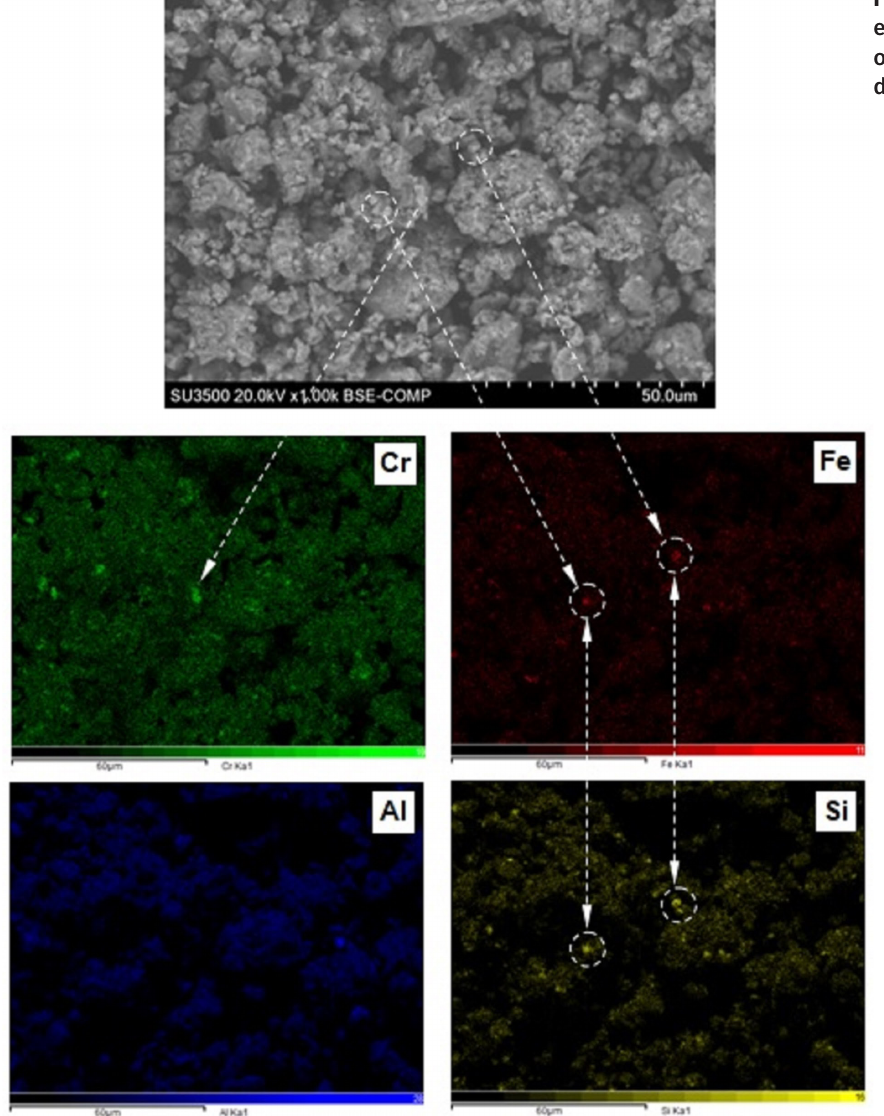
Figure 7. SEM images and elemental distribution of CrAlFeSi powder after deposition